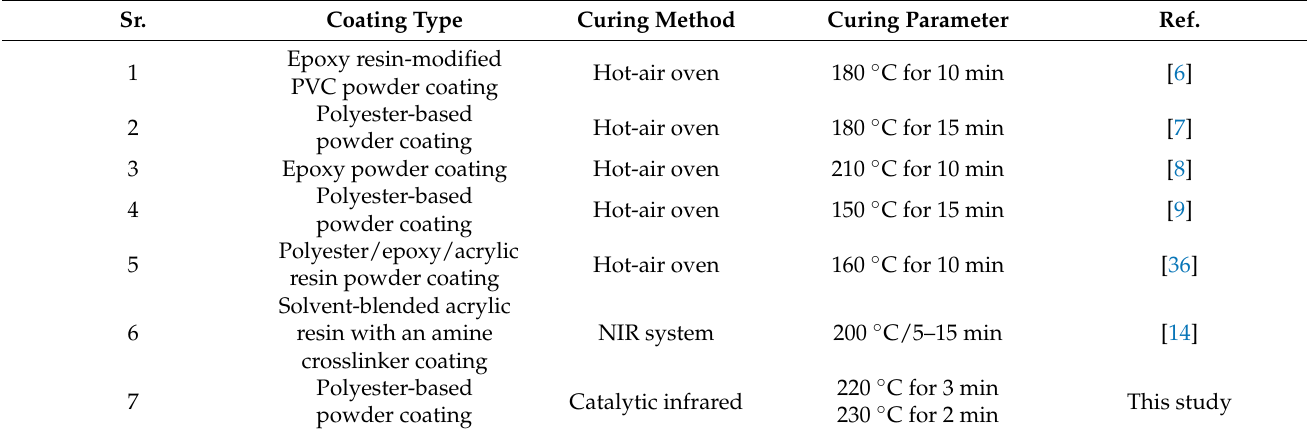
Table 5. Comparison of curing parameters with those obtained from the literature.